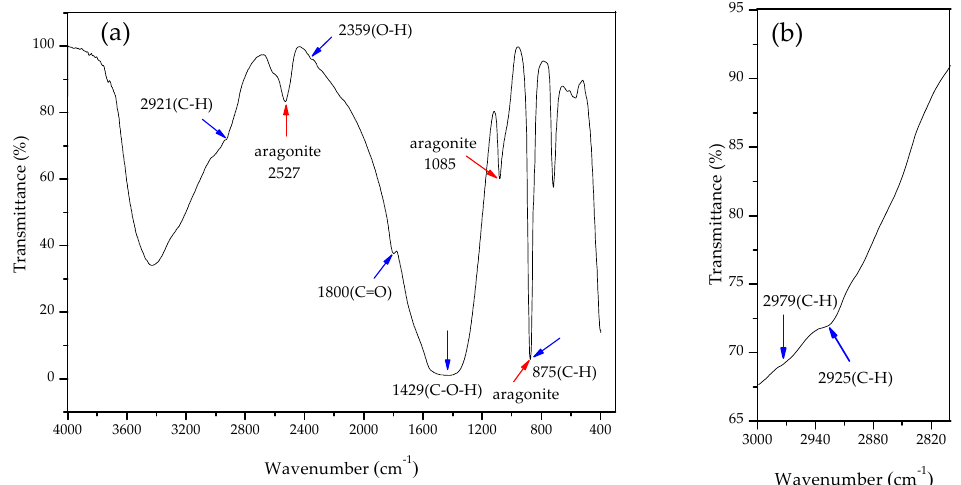
Figure 7. FTIR spectrogram of minerals formed at an Mg/Ca molar ratio of 2 in the experimental group containing MgCl 2 : ( a ) FTIR spectrogram of minerals from 4000 cm − 1 to 400 cm − 1 ; and ( b ) partial enlarged view of the spectrogram from 3000 cm − 1 to 2800 cm − 1 .